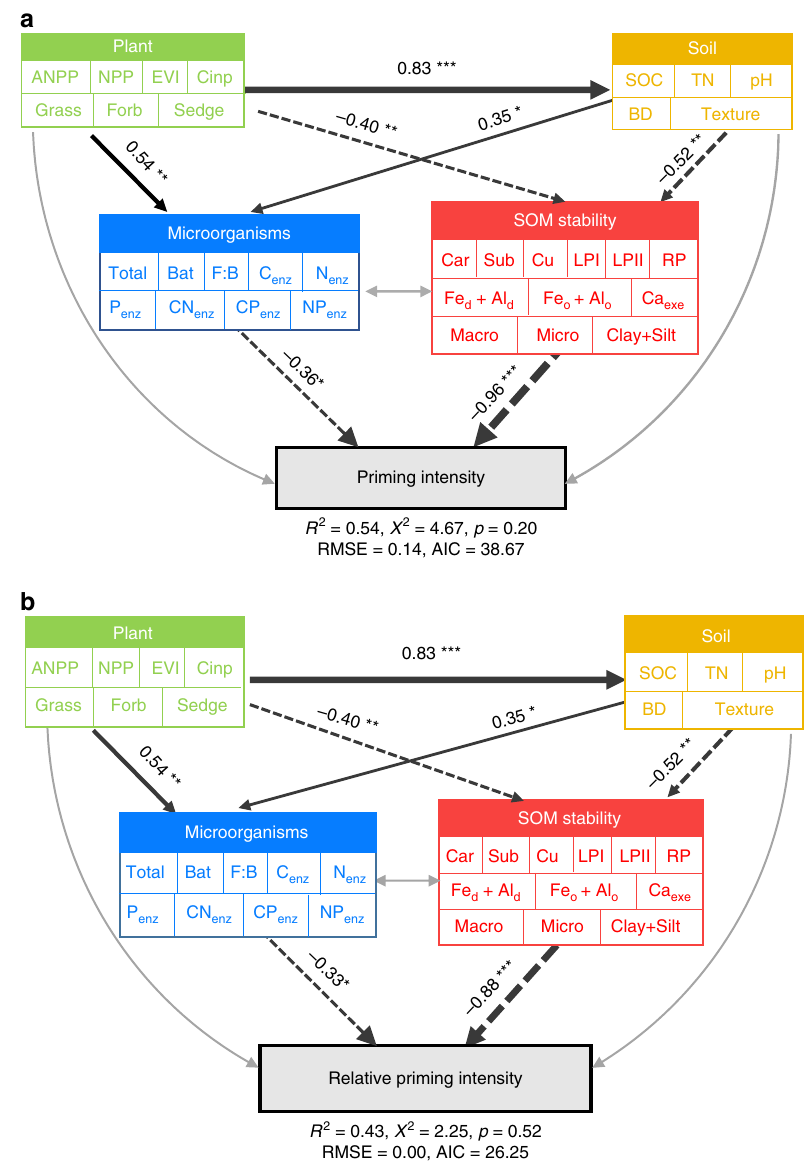
Fig. 4 Direct and indirect effects of soil organic matter stability, plant, soil and microbial properties on the priming effect. The structural equation modelling was conducted for two forms of priming effect: a absolute priming intensity; b relative priming intensity. Single-headed arrows indicate the hypothesized direction of causation. Black solid and dotted arrows indicate positive and negative relationships, respectively. Grey arrows indicate insigni fi cant relationship. The arrow width is proportional to the strength of the relationship. Multiple-layer rectangles represent the fi rst component from the PCA conducted for the plant, soil and microbial properties, and soil organic matter stability. The plant properties include aboveground net primary production (ANPP), net primary productivity (NPP), C input amount (Cinp), and the relative coverage of grass, forb and sedge; the soil properties include the soil organic carbon (SOC) content, total nitrogen (TN) content, pH, bulk density (BD) and texture; the microbial properties include the total PLFAs (Total), bacterial PLFAs (Bat), F/B ratio, C-acquiring enzyme activity (C enz ), N-acquiring enzyme activity (N enz ), P-acquiring enzyme activity (P enz ), C:N ratio of enzyme activity (CN enz ), C:P ratio of enzyme activity (CP enz ), and N:P ratio of enzyme activity (NP enz ); the SOM stability includes carbohydrates (Car), suberin-derived compounds (Sub), cutin-derived compounds (Cu), labile pool I (LPI), labile pool II (LPII), the recalcitrant pool (RP), molar ratios of free and amorphous Fe/Al oxides to the SOC ratio (Fe d + Al d and Fe o + Al o ), ratio of exchangeable Ca to SOC (Ca exe ) and the proportions of SOC in macroaggregates (Macro), microaggregates (Micro) and clay + silt fractions. The numbers adjacent to the arrows are the standardized path coef fi